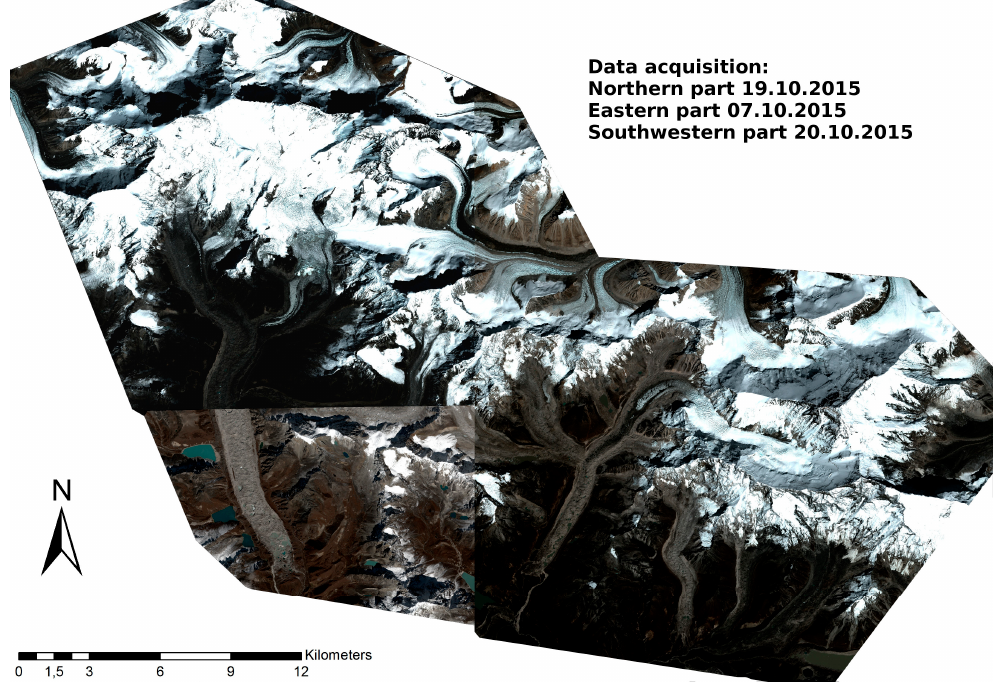
Figure 3. Overview of the autumn 2015 Pl é aides images of the Khumbu Himal study area. UTM 45